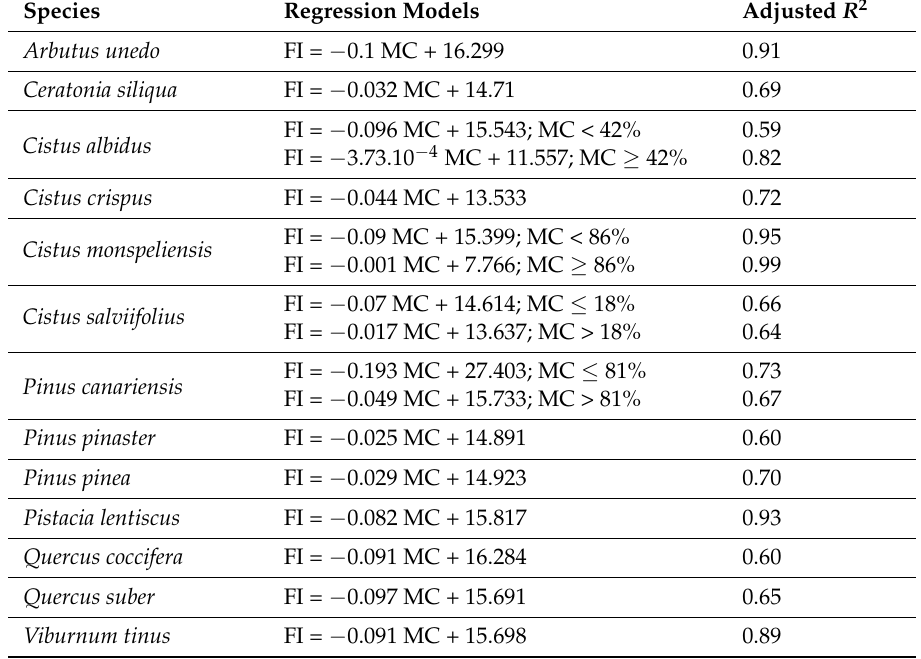
Table 6. Regression models of flammability index vs. moisture content of some dominant Mediterranean forest fuels. Species Regression